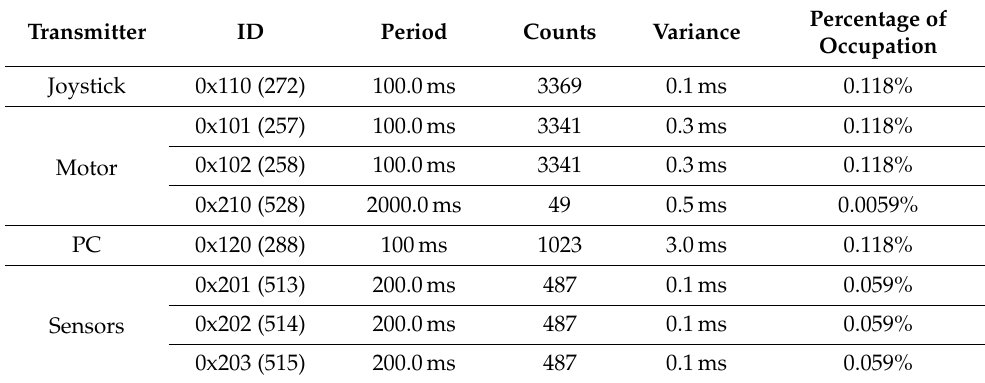
Table 2. Timing on the CAN bus.